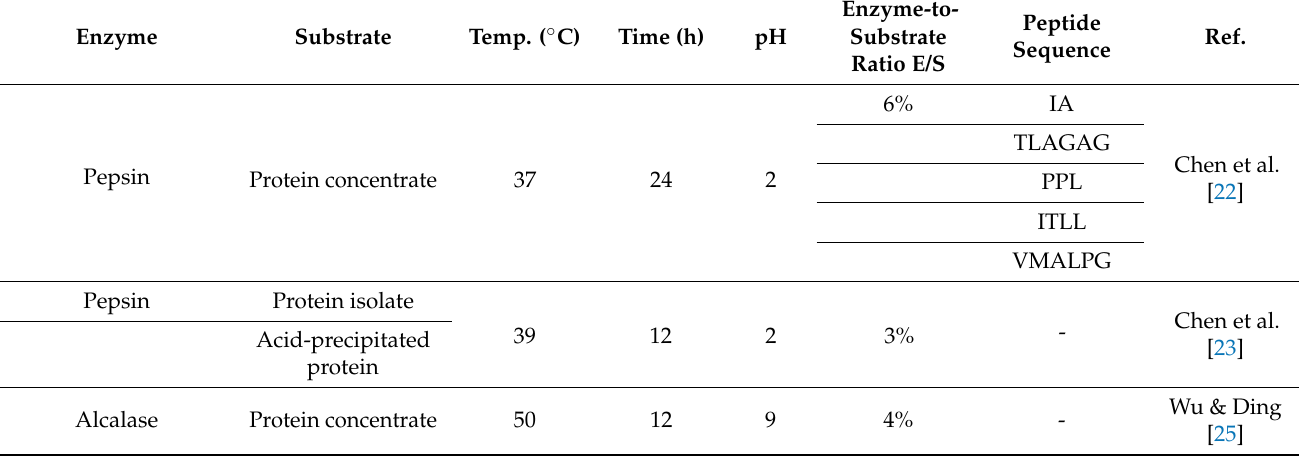
Table 1. Enzymatic hydrolysis conditions of soybean proteins using endopeptidases to produce ACEi peptides.